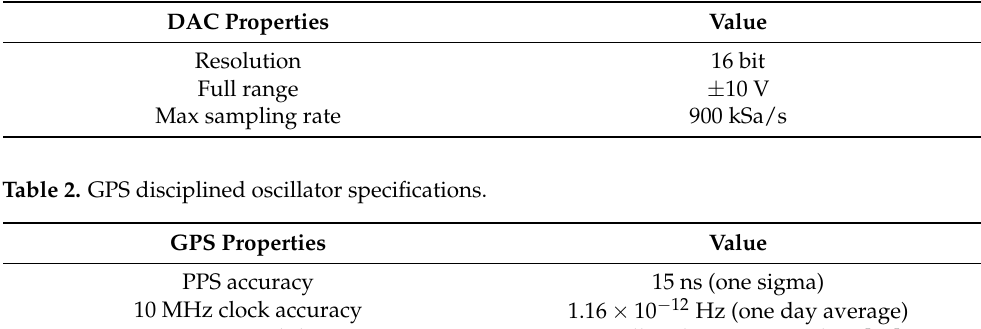
Figure 2. Schematics of the calibrator architecture. Table 1. Calibrator’s analog output DAC specifications.